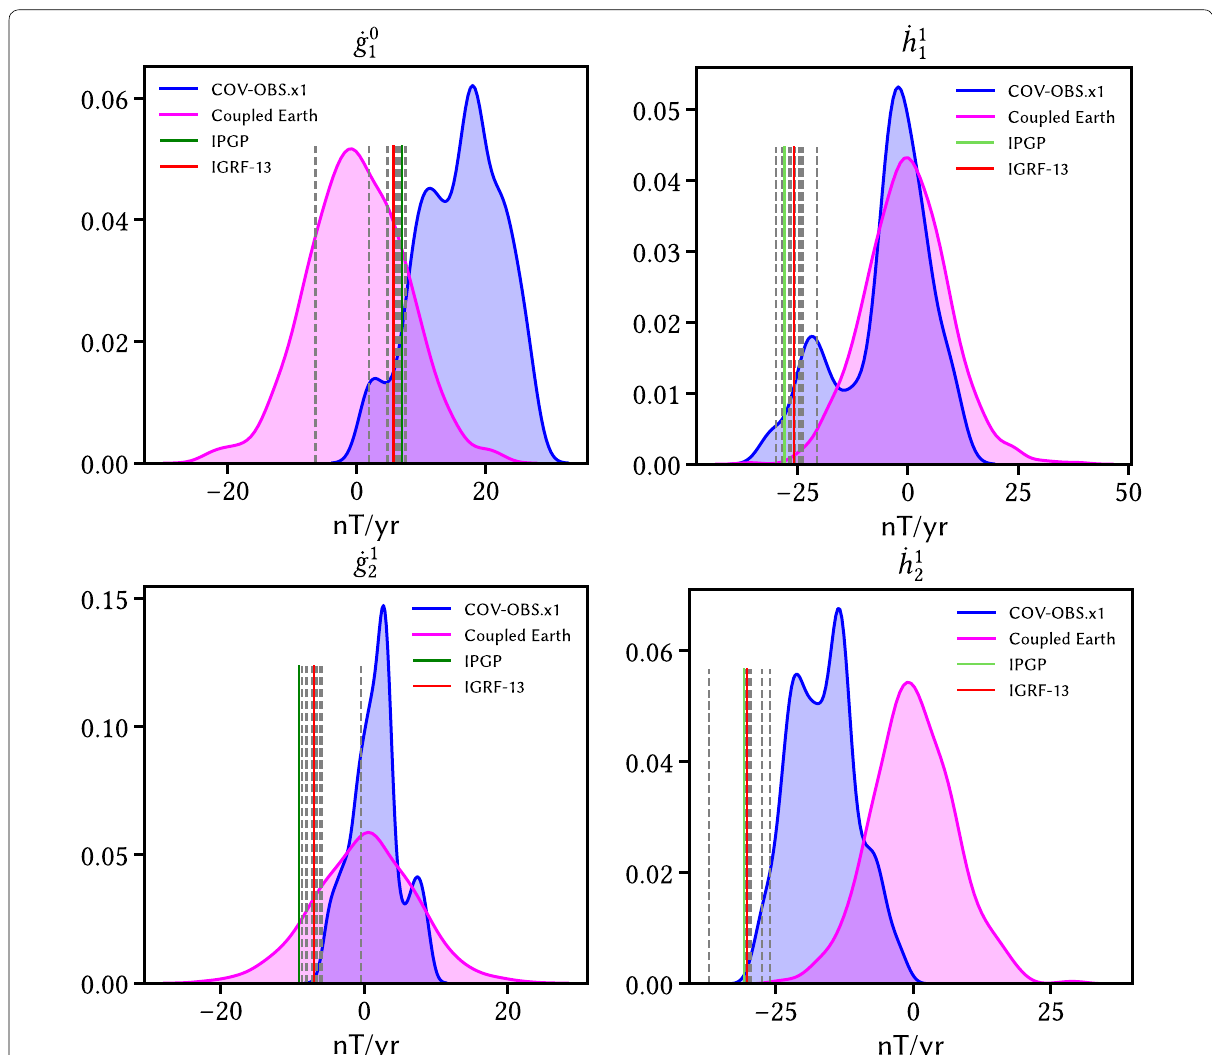
Fig. 7 Distribution of proposed rates of change for some Gauss coefficients of degrees 1 and 2 against the statistics of the COV-OBS.x1 geomagnetic field model (Gillet et al. 2015) and the Coupled Earth dynamo model (Aubert et al. 2013). The grey dashed lines correspond to the rates of change proposed by the 13 other SV candidates to